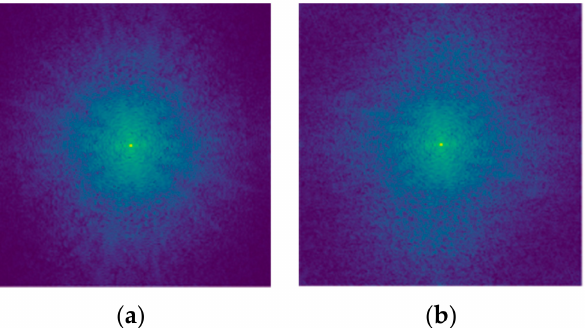
Figure 10. The ( a ) image is the frequency domain of a clean image and the ( b ) is the frequency domain of an adversarial